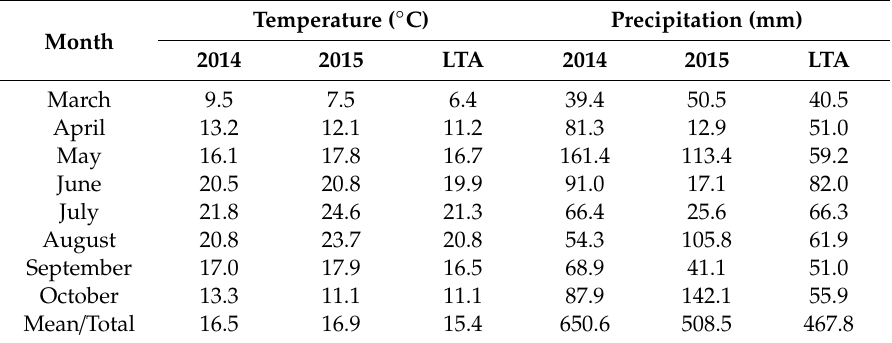
Table 1. Average air temperature ( ◦ C) and monthly precipitation (mm) in Osijek, Croatia from March to October and a long-term average